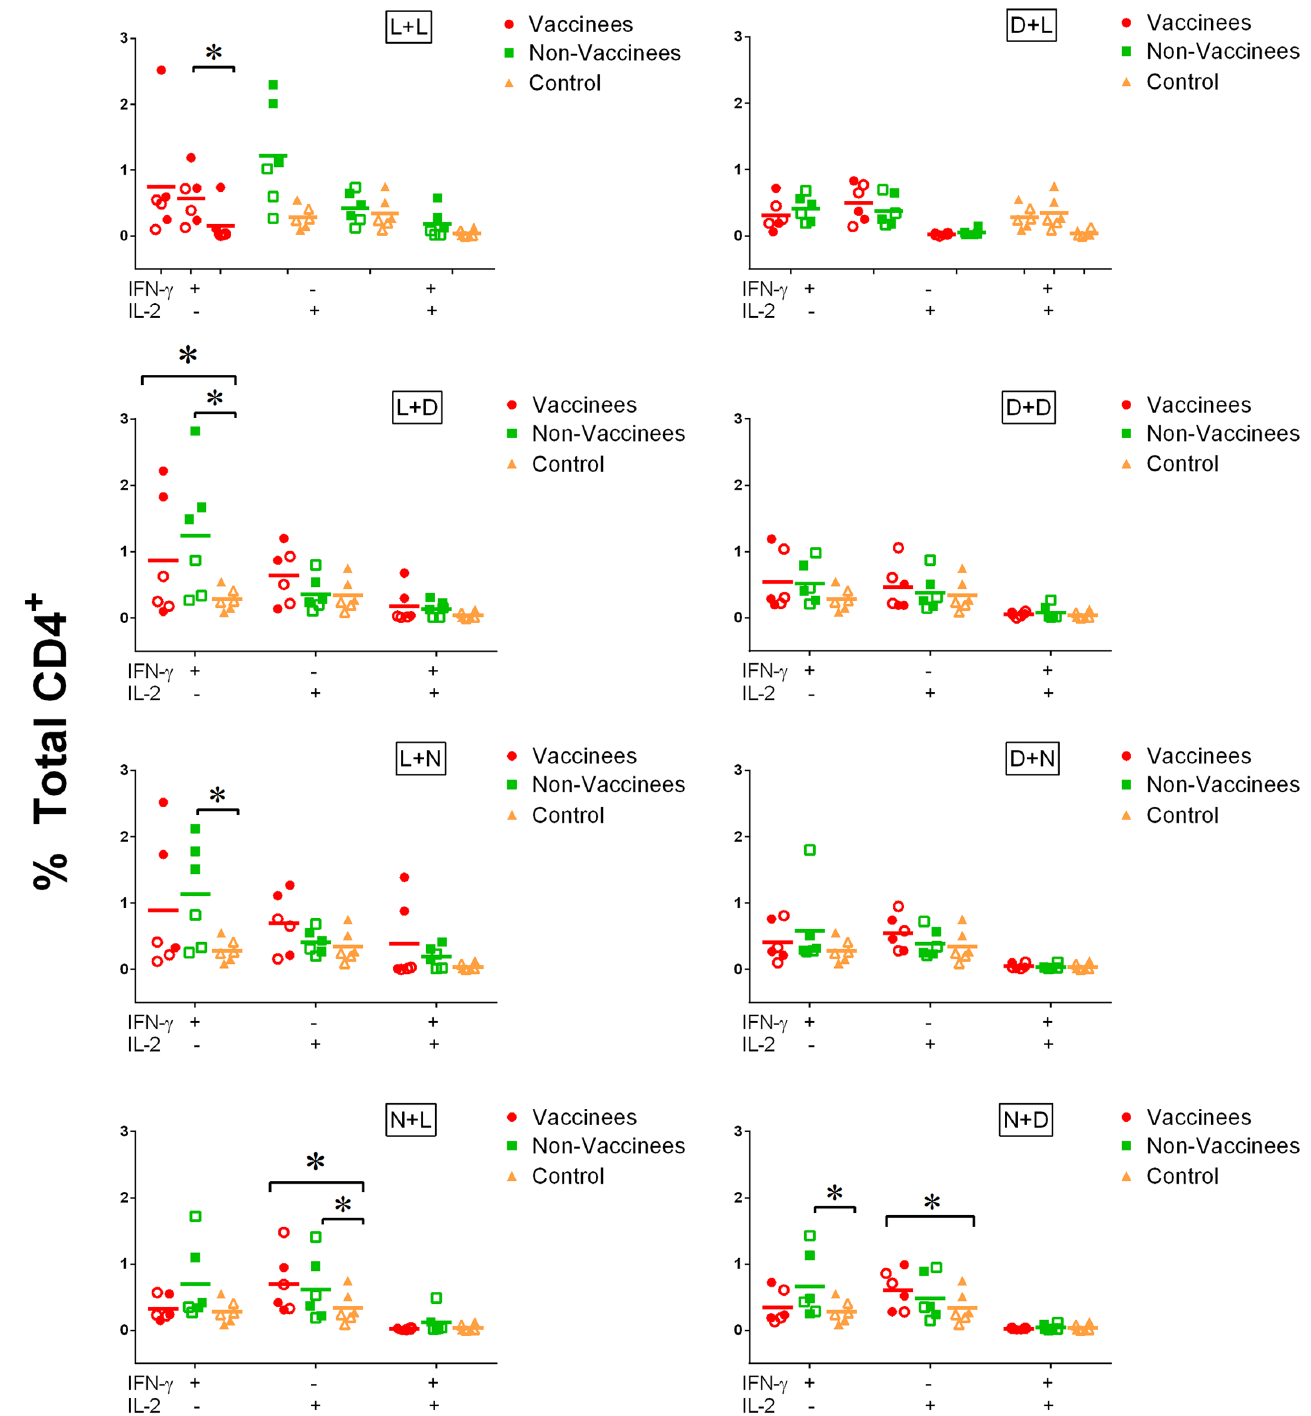
Fig 9. Cytokine response in CD4 + T cells: Vaccinated vs. unvaccinated. IFN- γ and IL-2 production by human CD4 + T cells in re-stimulation assays. Each data point represents the response from an individual donor (n = 6) with the horizontal bar indicating the mean of the six values. Red circles indicate cells isolated from vaccinated donors and green squares indicate cells isolated from unvaccinated donors. Yellow triangles indicate mock-treated (N+N) control cells. Closed data points indicate cells infected with YFV 17D while open data points indicate cells infected with YFV Asibi. (L) indicates treatment with live virus, (D) indicates treatment with gamma-irradiated inactivated virus and (N) indicates mock-treated MoDC prior to co-culturing with CD4 + T cells (See Fig 7 and Materials and Methods). ( * ) indicates points of significant (p < 0.05) difference between the indicated datasets (bracket). A non-parametric multi-T test was used to determine statistical significance. doi:10.1371/journal.pntd.0004709.g009 PLOS Neglected Tropical Diseases | DOI:10.1371/journal.pntd.0004709 May 18,